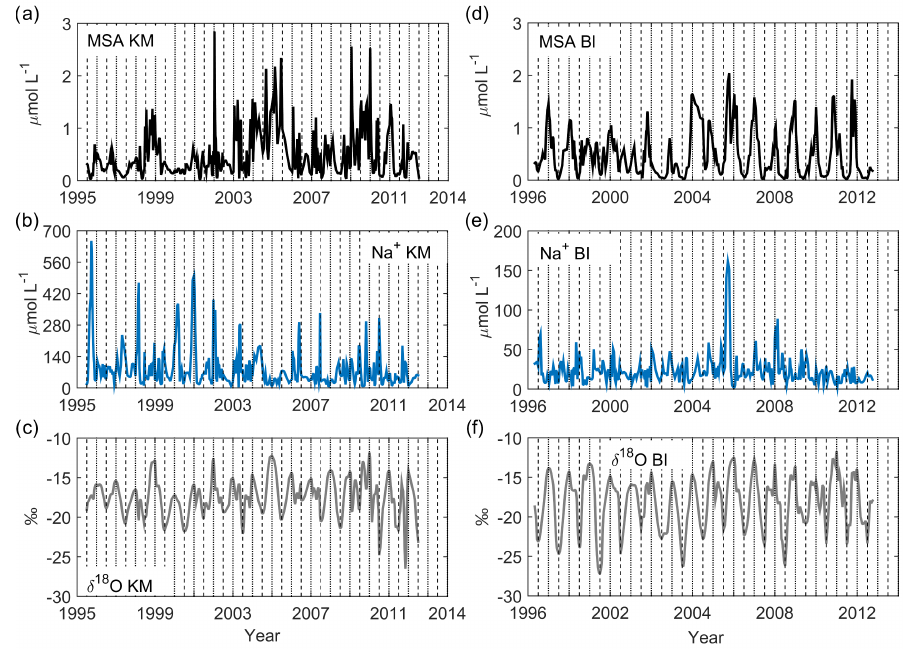
Figure 3. Seasonality of (a) MSA, (b) Na + , and (c) δ 18 O for the KM and BI cores. Dashed lines and dotted lines indicate winter (summer) minima (maxima). An MSA outlier observed in year 2002 in the KM core was removed from the series since it was 30 times higher than the median MSA values.